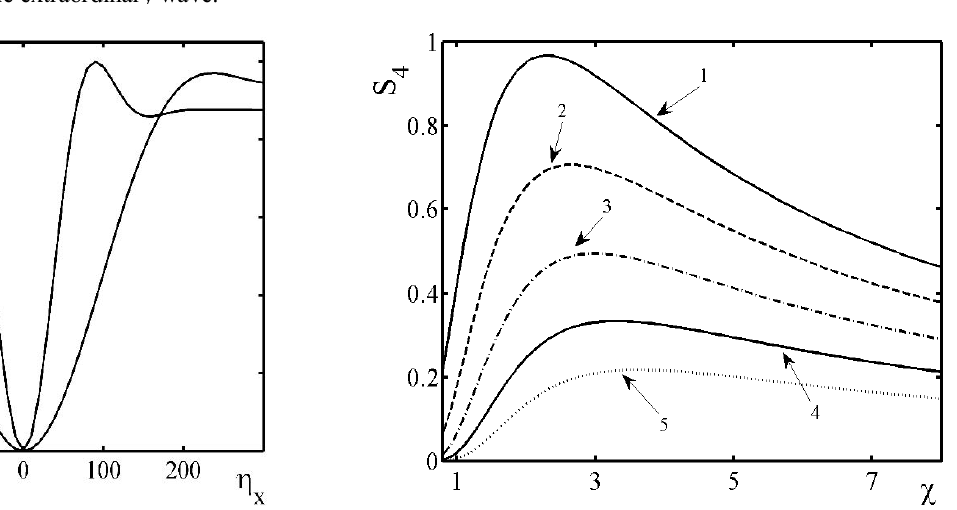
Figure 4: The width of the SPS in the XZ plane versus parameter for the extraordinary wave.